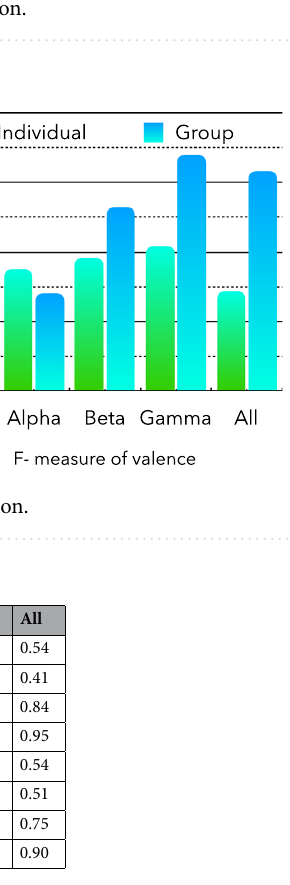
Figure 4. Accuracy and F-measure of arousal emotion prediction.